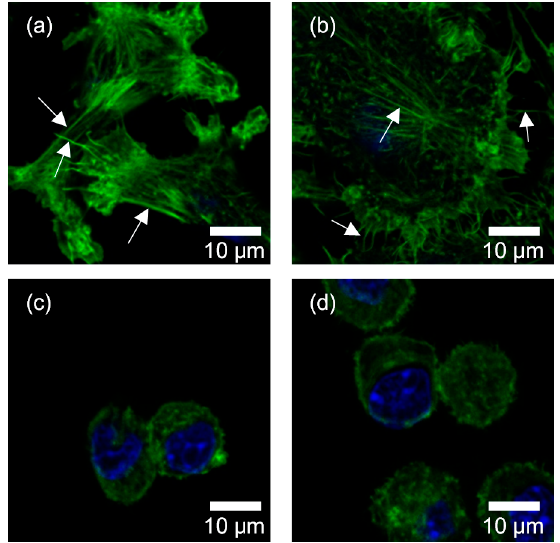
Figure 7. Fluorescent images of actin filaments (green) and nuclei (blue). ( a ) Adhered B16-F1 cells, ( b ) adhered B16-F10 cells, ( c ) floating B16-F1 cells, and ( d ) floating B16-F10 cells. Arrows in ( a , b ) indicate actin filaments whose thickness was